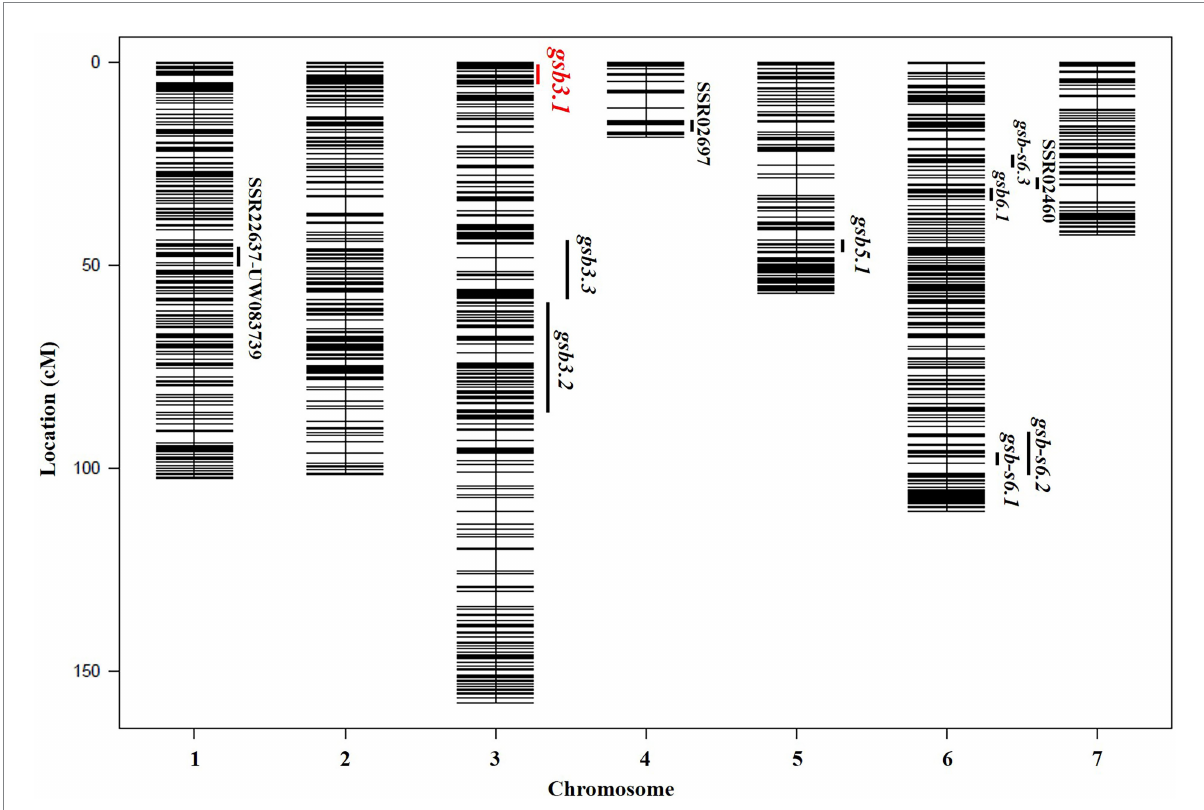
FIGURE 3 Genetic map and distribution of reported QTLs for GSB resistance at the seedling stage in cucumber. The gsb3.1 QTL in this study is indicated in